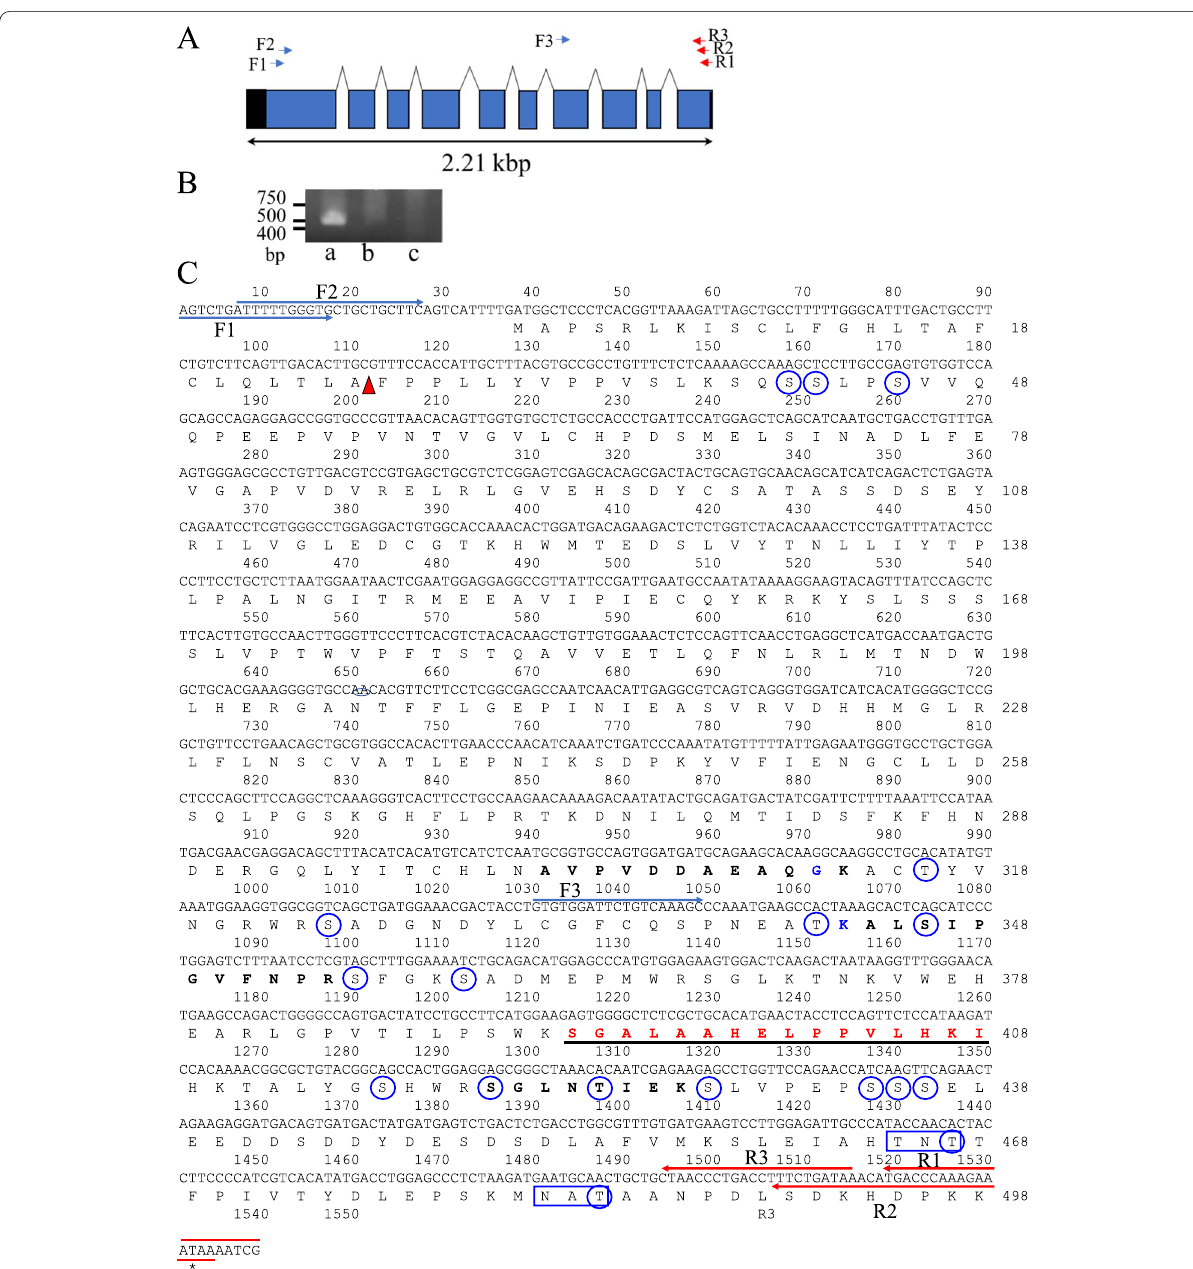
Fig. 2 Cloned cDNA encoding mZPC5 in the ovaries and livers of spawning medakas. A: the genomic structure of mzpc5 and the primer position used to identify mzpc5 expression and clone full-length cDNA. The diagrammed pattern of the genomic structure is based on information from the Ensemble Project database [36]. The blue and red arrows indicate the positions of forward (F1, F2, F3) and reverse (R1, R2, and R3) primers, respectively, that were used for RT-PCR. B : the result of the RT-PCR analysis. Ba: RNA obtained from the spawning female ovary. Bb: RNA obtained from the spawning female liver. Bc: RNA obtained from male liver. C : the nucleotide and predicted amino acid sequences of newly cloned mzpc5 cDNA in this study. A one-letter symbol represents each amino acid as defined by the International Union of Pure and Applied Chemistry (IUPAC). The red arrowhead points to the signal sequence cleavage site analyzed using PSORT [37]. Underlined amino acid sequences with bold red letters represent the antigen peptide sequence. The blue and red arrows indicate the locations of primers used for RT-PCR analysis. Blue-circled letters indicate the predicted amino acids connecting to O-linked oligosaccharides [38]. Letters boxed in blue represent the predicted peptide sequence at the N-glycosylation site [39]. Bold blue amino acids ( 312 G and 343 K) differ from the amino acids in ZPC5 (accession # AAN31192). The amino acid sequences of the peptides shown in bold black letters were obtained from the immunoreactive proteins (~74 kDa) in Figs. 4b and 5b following MS/ MS